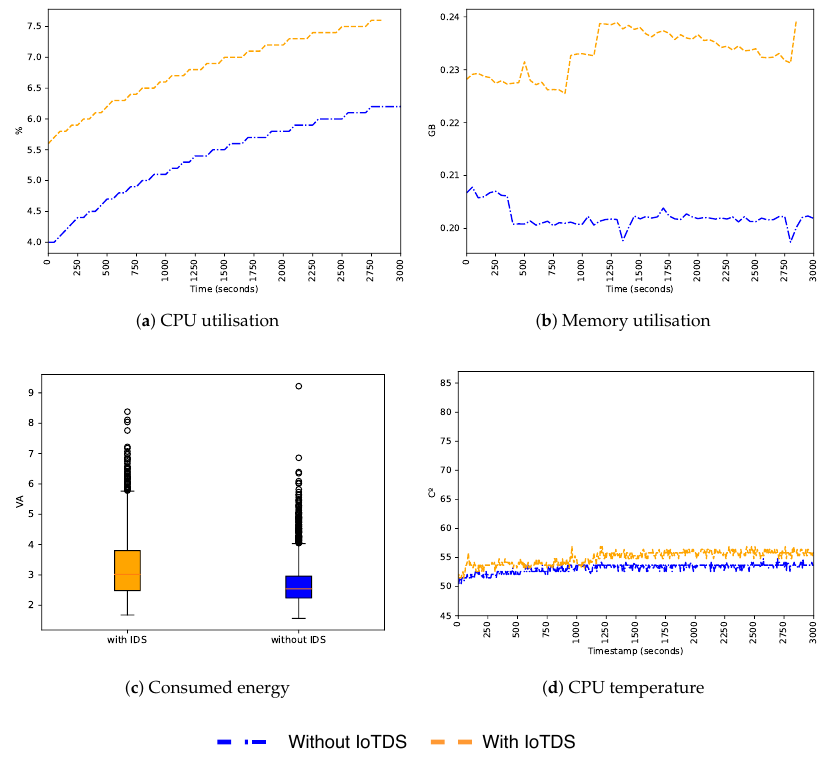
Figure 7. Behaviour of the MC profile regarding host’s resource usage with and without the IoTDS.